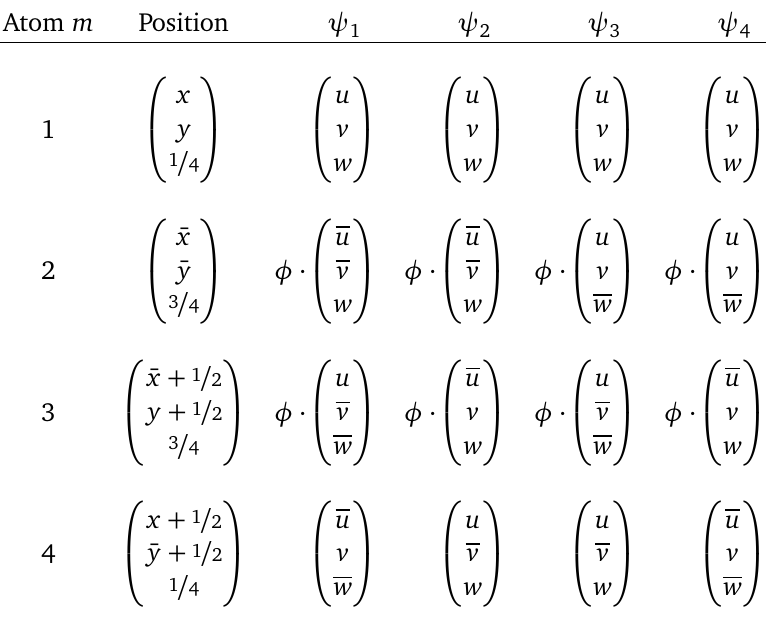
Table 2: Basis vectors ψ ( n = 1-4) of the irreducible representations Γ n ions m = 1-4 at given fractional coordinates ( x , y , z ) associated with a propagation vector q = ( 00 1 / 3 ) . The components u , v and w connected to the spin S m refined according to their constraints (an overline indicates a negative number). The phase factor φ = exp ( − 2 π i qr ) results from the translation r = ( 00 1 / 2 ) associated with the screw axis parallel to the c axis or r = ( 0 1 / 21 / 2 ) connected to the glide plane perpendicular to the a